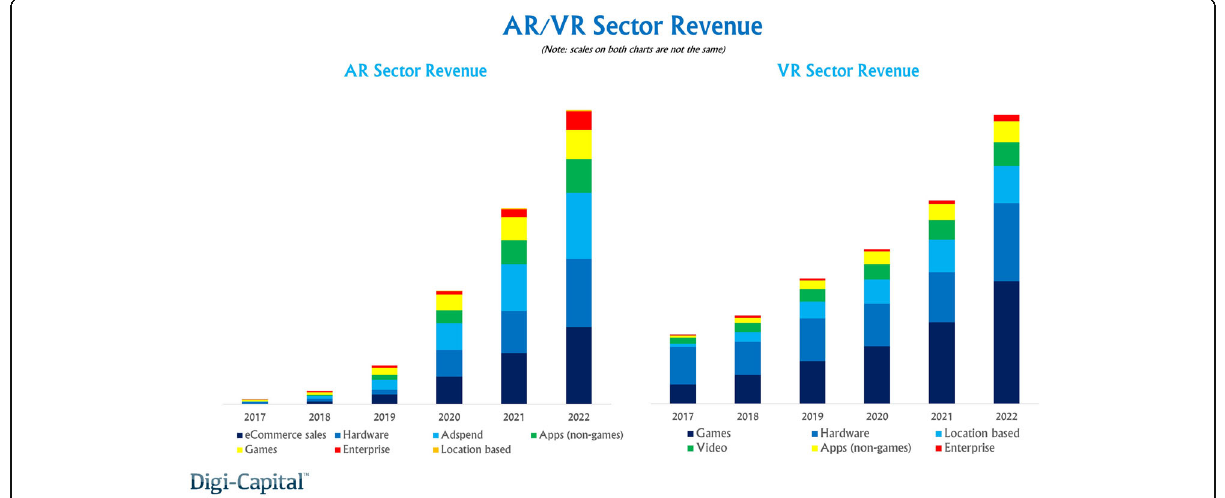
Fig. 2 AR/VR sector revenue. The VR/AR sector revenue on mobile from 2017 to